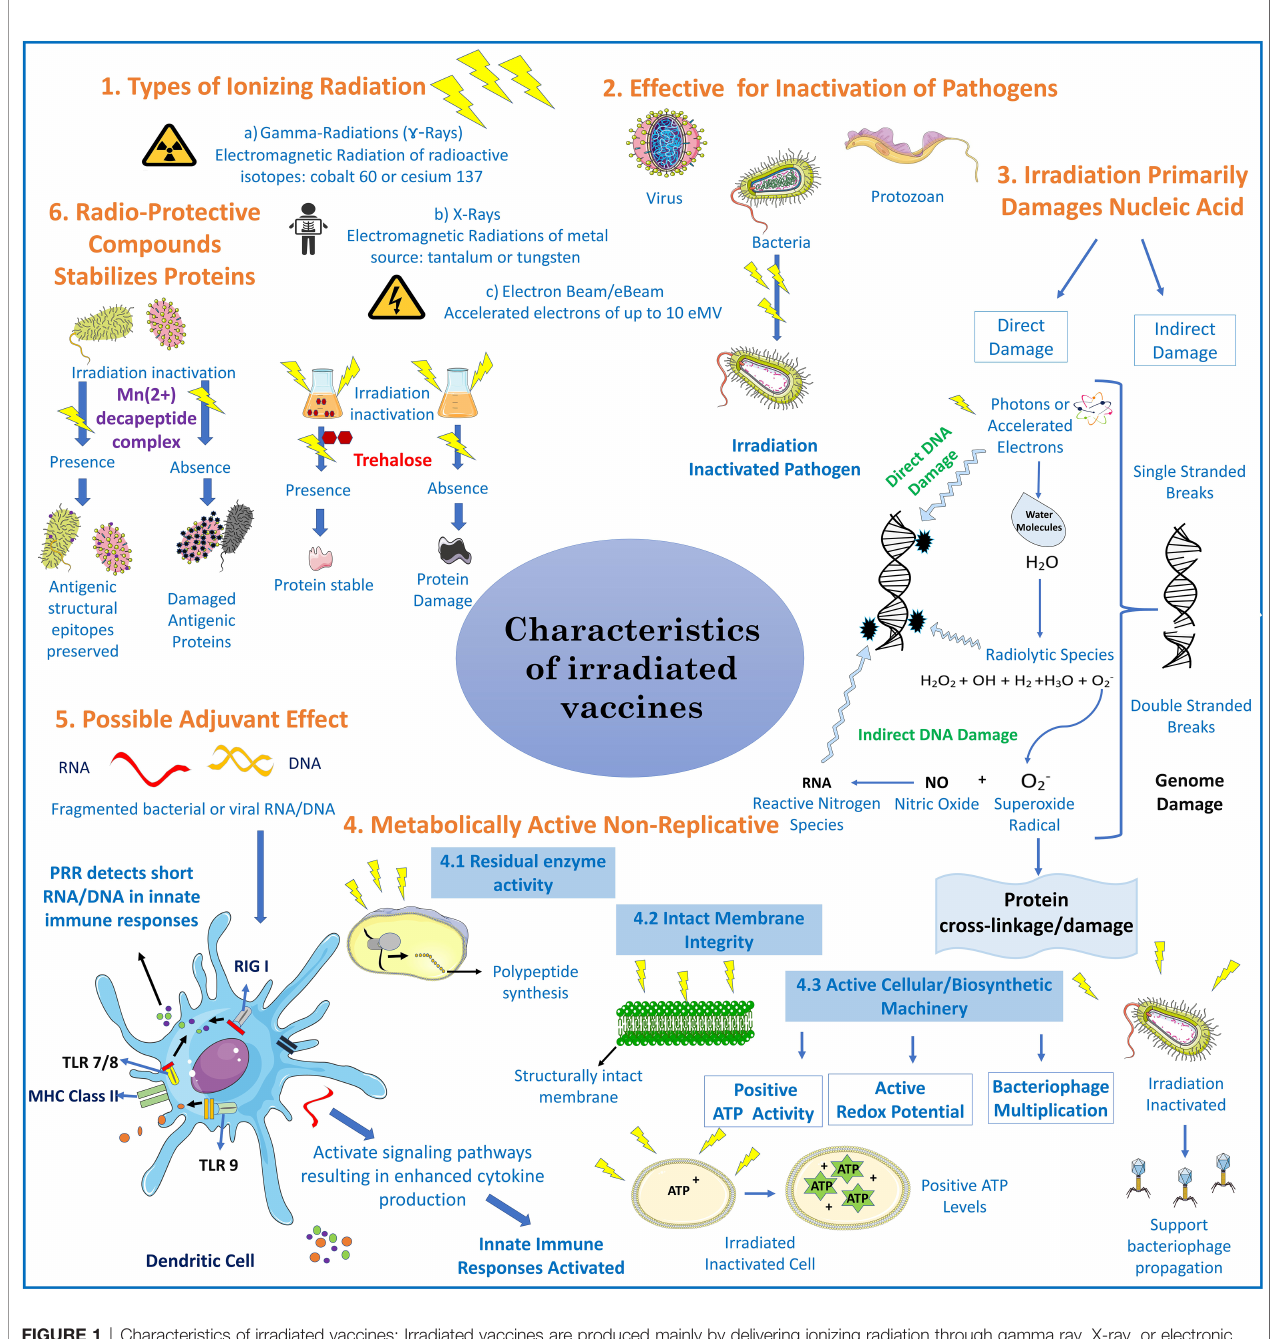
FIGURE 1 | Characteristics of irradiated vaccines: Irradiated vaccines are produced mainly by delivering ionizing radiation through gamma ray, X-ray, or electronic beam (e-Beam) irradiation (13). The mechanism behind inactivation of pathogens is through direct and indirect damage of genetic material (DNA/RNA) and cross linking of proteins. Direct genome damage is by contact of photons (from gamma-rays/X-rays) or accelerated electrons (10eMV mega electron volt) through the breakage of phosphodiester bonds (14). Indirect damage is by highly reactive short lived radiolytic species such as hydrogen peroxide (H 2 O 2 ), hydroxyl radical, hydrogen (H 2 ) and superoxide radicals (O − 2 ), that are the product of endogenous water molecules radiolysis. O − 2 can cause protein cross linkage and upon its reaction with nitric oxide it can generate reactive nitrogen species (RNS) that damages nucleic acids (15). In bacteria and parasites, irradiation stops replication yielding metabolically active organisms that present structural antigens and functional proteins in a vaccine as reported through ATP production, redox potential, or bacteriophage multiplication (16). Irradiation produces short RNA/DNA fragments which activate pathogen pattern recognition receptors (PRR)s, for example retinoic acid-inducible gene I (RIG I) or toll like receptors (TLR ’ s) in the innate immune system thus acting as a vaccine adjuvant (12). Adding radio-protective compounds such Mn2+-decapeptide complex (MDP) derived from Deinococcus radiodurans or trehalose preserves immunogenic epitopes (10,